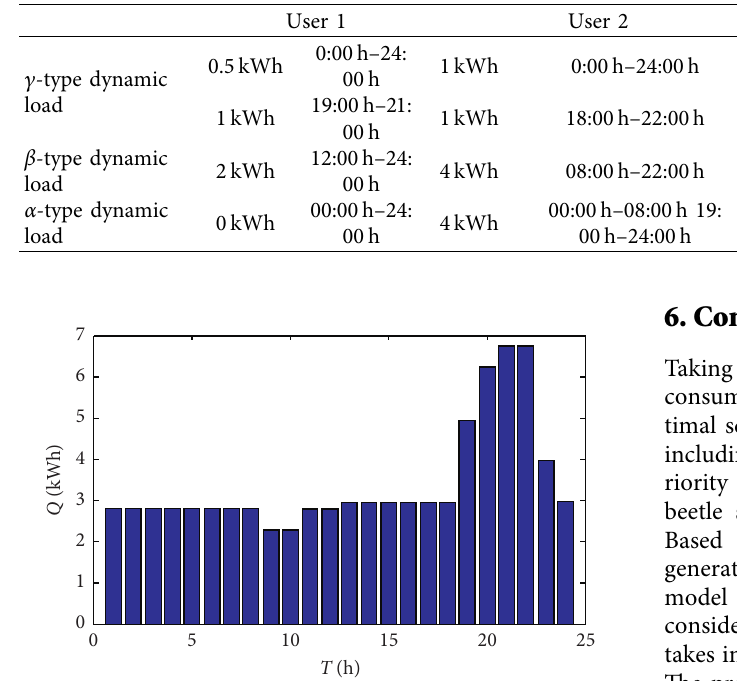
Figure 2: Load without smart use of electricity.